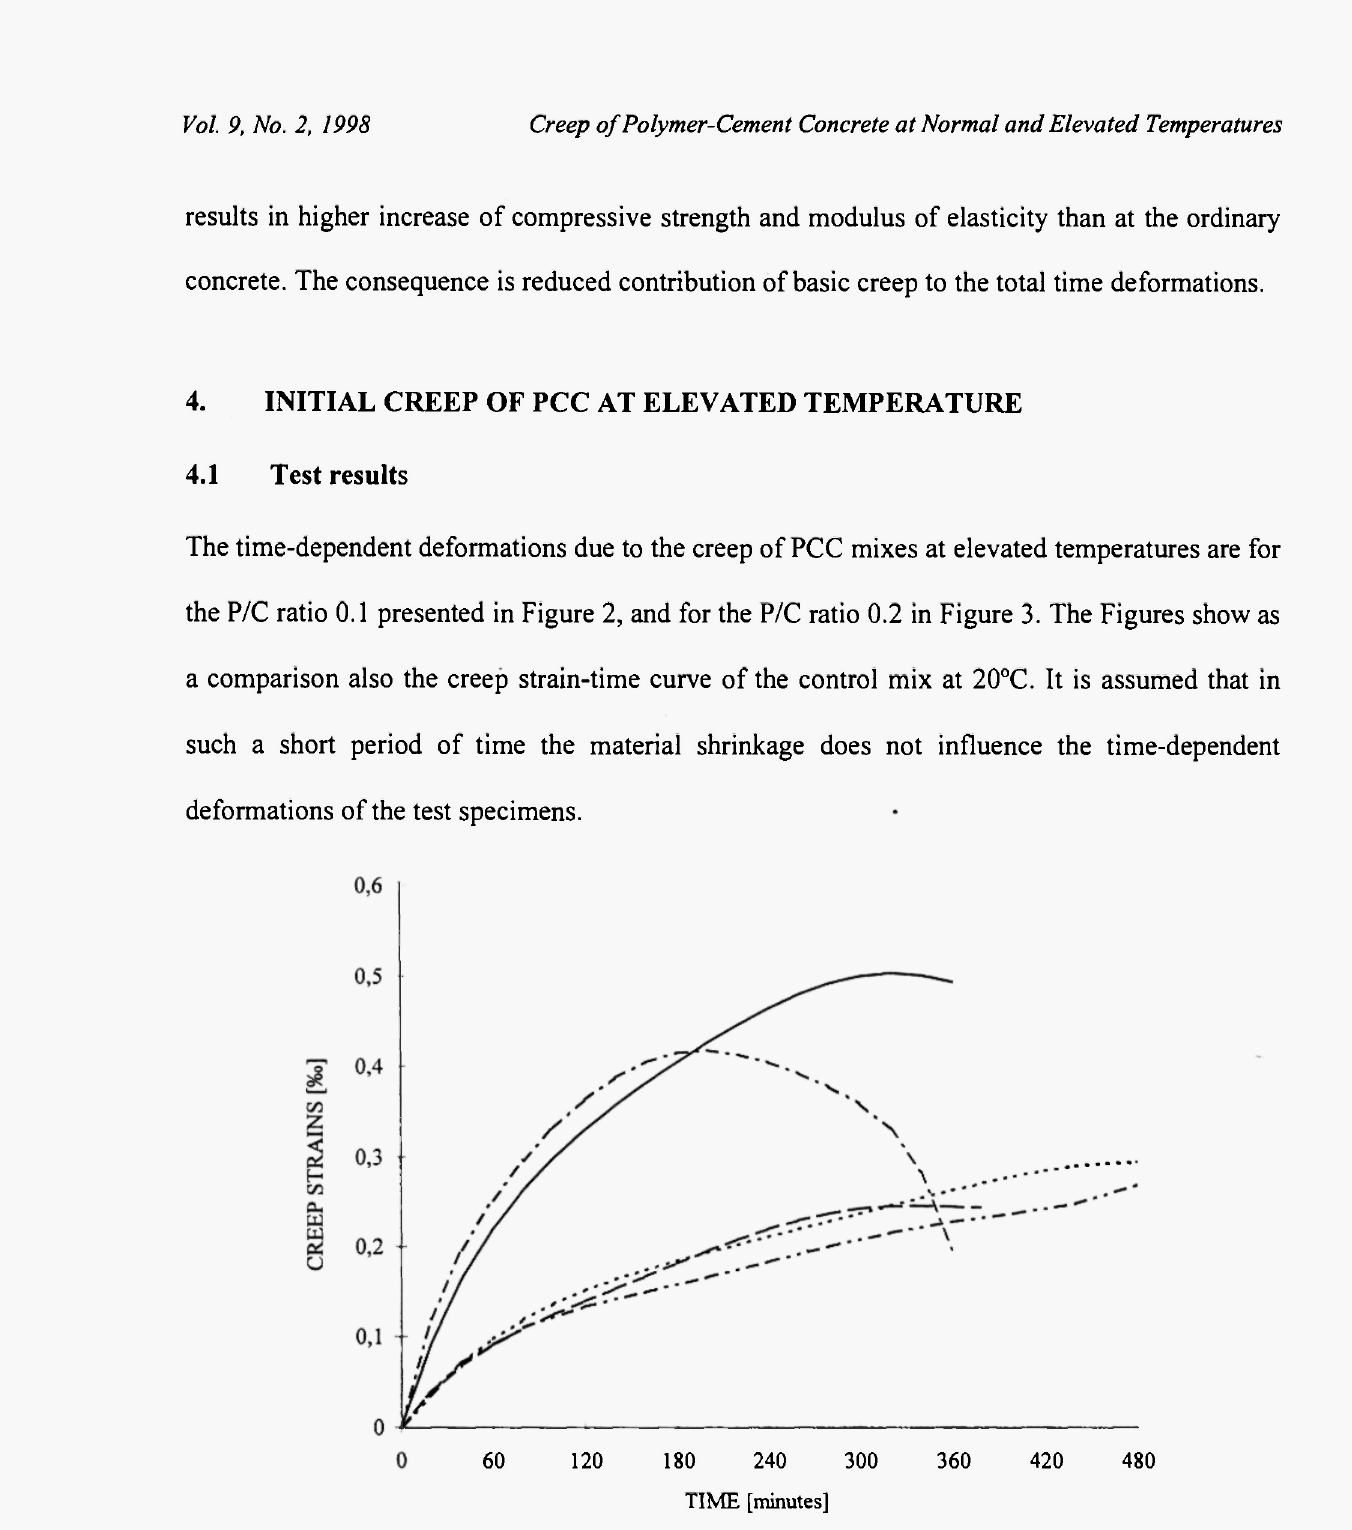
Figure 2: Initial creep deformations of PCC with P/C ratio 0.1 at elevated